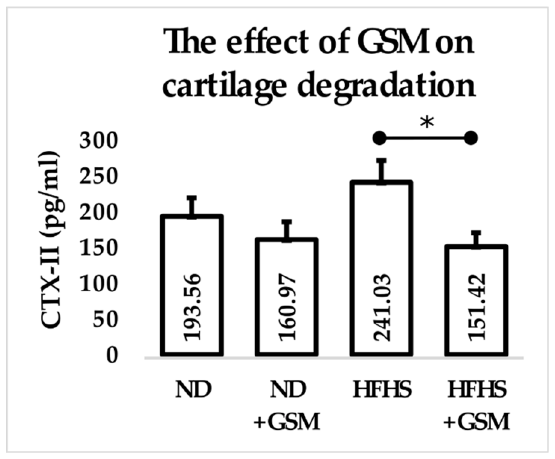
Figure 2. Modulation of cartilage degradation by diet. Plasma samples were assessed in duplicate for C-terminus telopeptide of type II collagen (CTX-II) by competitive ELISA. Data are shown as mean + standard deviation of n = 11–12 rats per group, and the mean values inserted into each bar. * p ≤ 0.05 between the groups within a diet by Student’s t -test.